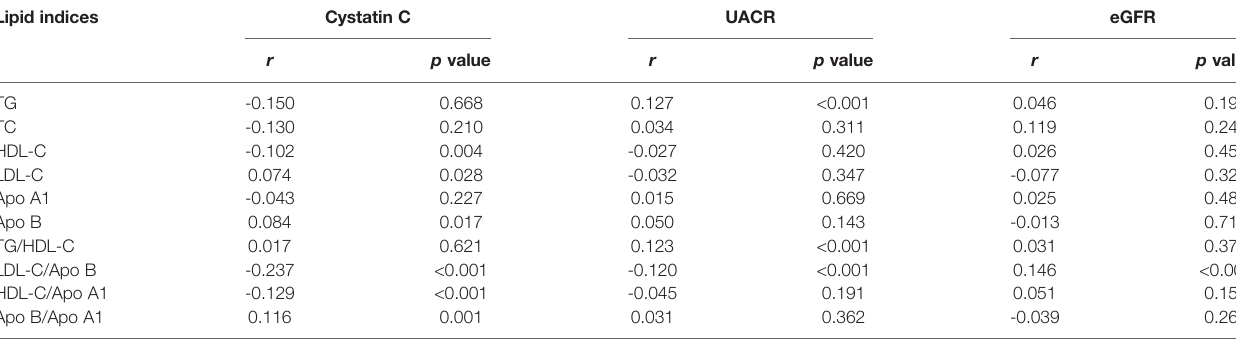
TABLE 2 | Relationships between lipid indices and kidney damage indices in patients with T2D. Lipid indices Cystatin C UACR